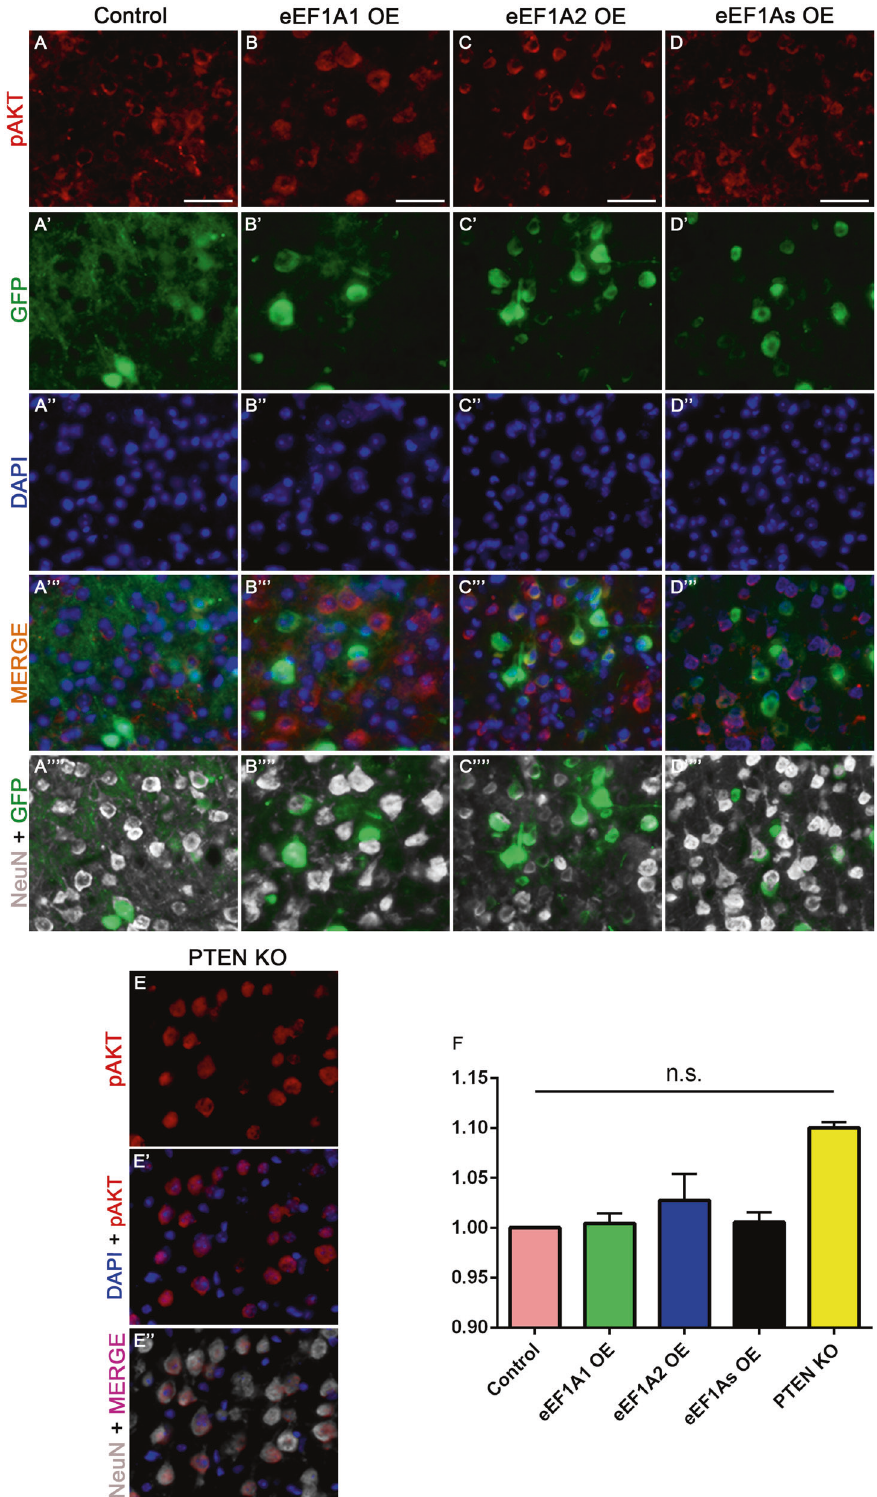
Fig. 6 Overexpression of eEF1A proteins does not increase pAKT phosphorylation. Representative images of pAKT, GFP (viruses), and NeuN staining at the layer V of the right sensorimotor cortex of injured control mice (AAV-GFP injection) ( A – A ”” ); injured eEF1A1-overexpressing (OE) mice ( B – B ”” ); injured eEF1A2-OE mice ( C – C ”” ); injured eEF1As-OE mice ( D – D ”” ); and injured PTEN cKO mice ( E – E ” ). F Quanti fi cation of pAKT immunoreactivity. Scale bars: 50 μ m. 4 mice per each genetic condition; 50 cells quanti fi ed per mouse. Stats: One-way ANOVA with Kruskal – Wallis Test. Bars show mean ±